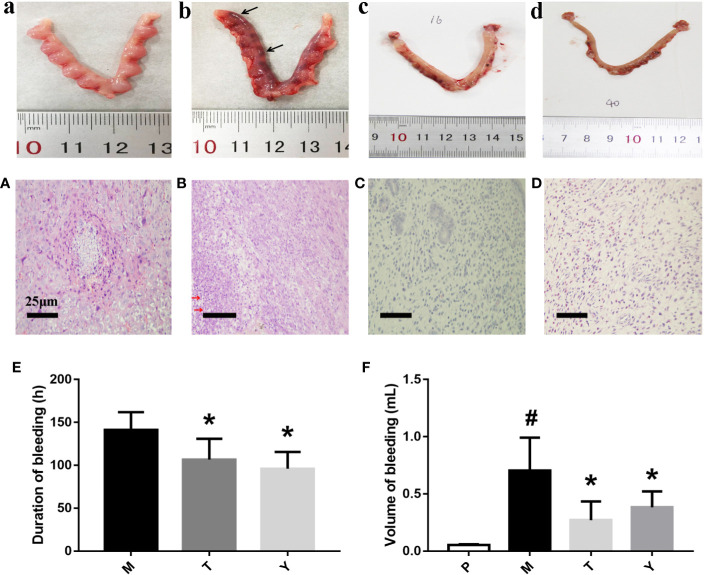
Macroscopic (a–d) and Pathological (A–D) observation of uteri tissue. Samples were performed with HE as described in Methods. a, A: group P; b, B: group M; c, C: group T. d, D: group Y. Black arrows indicate dark red residue, red arrows indicate necrotic decidual cells. Duration (E) and volume (F) of uterine bleeding. The duration of uterine bleeding was recorded from the beginning of uterine bleeding after the administration of mifepristone to the cessation of bleeding completely. The unit of duration was measured in hours. Adopting the method of Alkaline Hematin Photometric to measure the volume of uterine bleeding in different groups. The unit of volume is in ml. #P < 0.05 vs group P. *P < 0.05 vs group M.